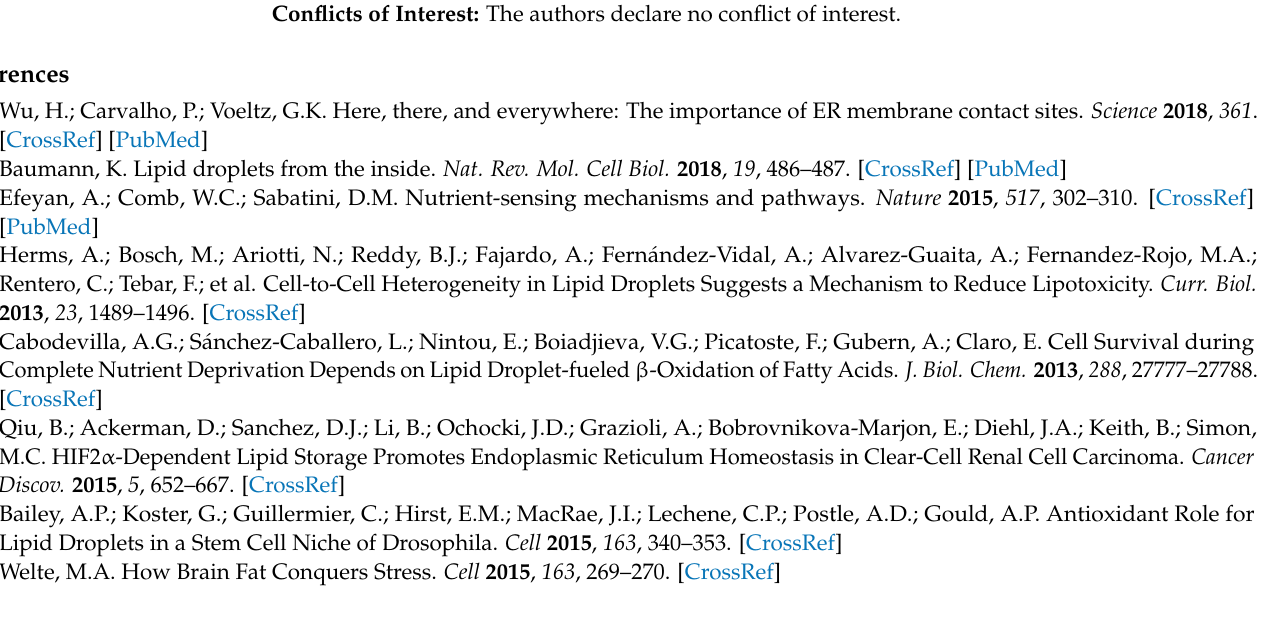
particles. Figure S2: The fluorescence distribution of Rhod-PE. Figure S3: Staining of NLPs using different dyes. Figure S4: Stability of nanolipid particles. Figure S5: Eutectic point curve of nanolipid particles. Figure S6: ApoB was recruited to nanolipid